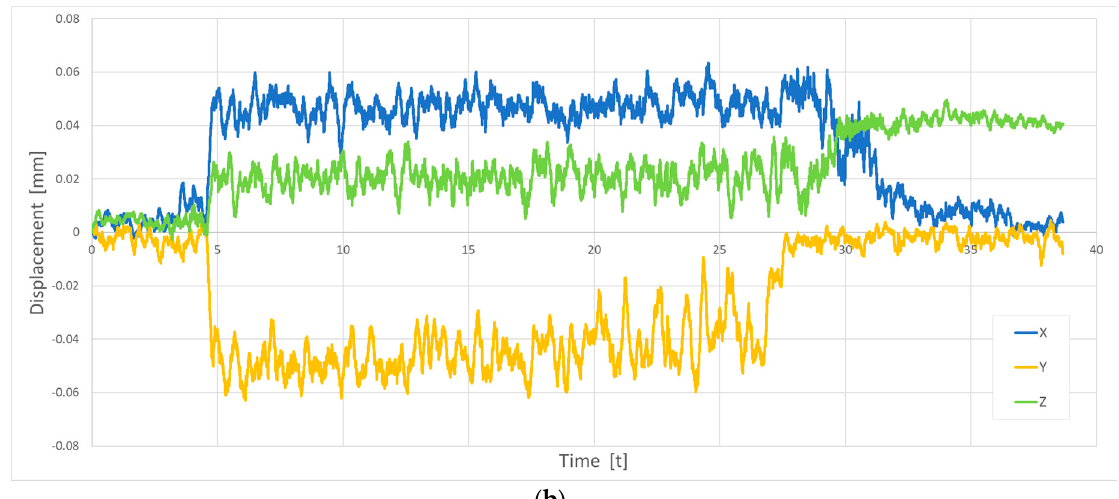
Figure 4. ( a ) Displacement of the post end (left). ( b ) Displacement of the post end (right).